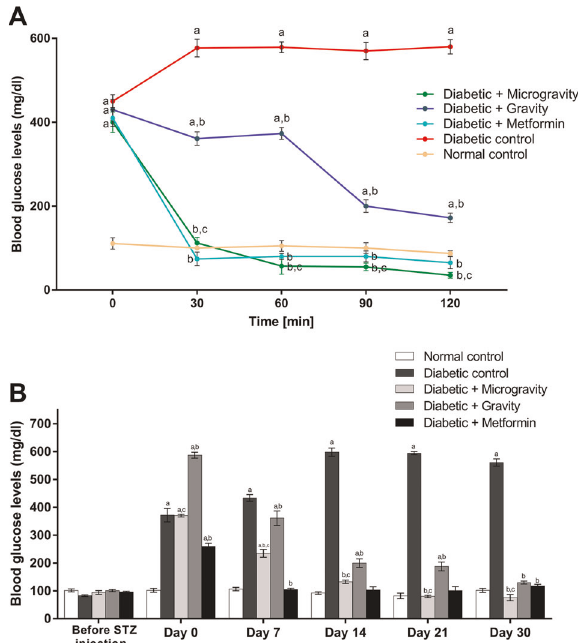
Fig. 2 The effects of ethanolic extracts of T. aestivum germinated under gravity and microgravity conditions on oral glucose tolerance tests over 2 h and fasting blood glucose levels over 30 days in experimental rats. a shows the effect of ethanolic extracts of T. aestivum under gravity and microgravity conditions on the results of the oral glucose tolerance test (OGTT). b shows the effect of ethanolic extracts of T. aestivum under gravity and microgravity conditions on fasting blood glucose levels in experi- mental rats. The values are expressed as the mean ± SEM of seven rats in each group. Data were analyzed by using two-way ANOVA followed by Tukey ’ s multiple comparison test with the level of signi fi cance set at P < 0.05. a refers to treatment versus normal control; b refers to treatment versus diabetic control; c refers to microgravity versus